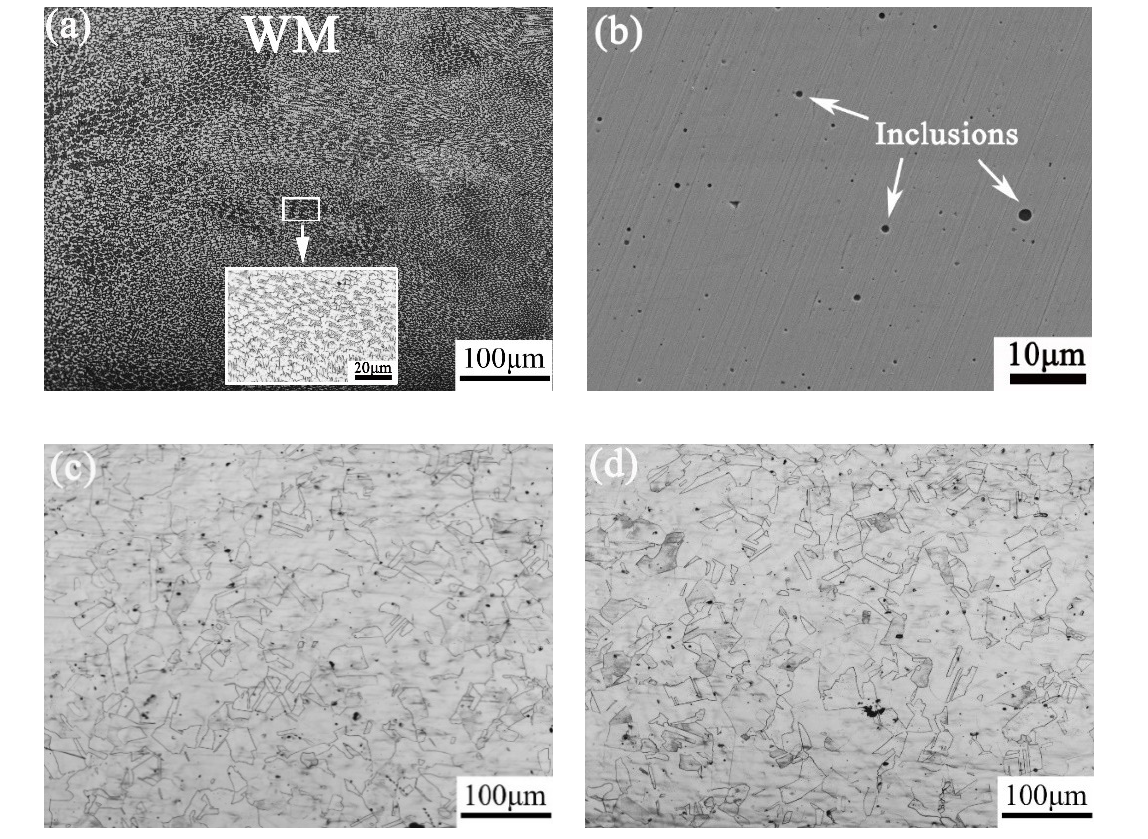
Figure 3. Microstructure of ( a ) weld metal (WM) with etching, ( b ) WM without etching, ( c ) heat-affected zone (HAZ), and ( d ) base metal (BM).